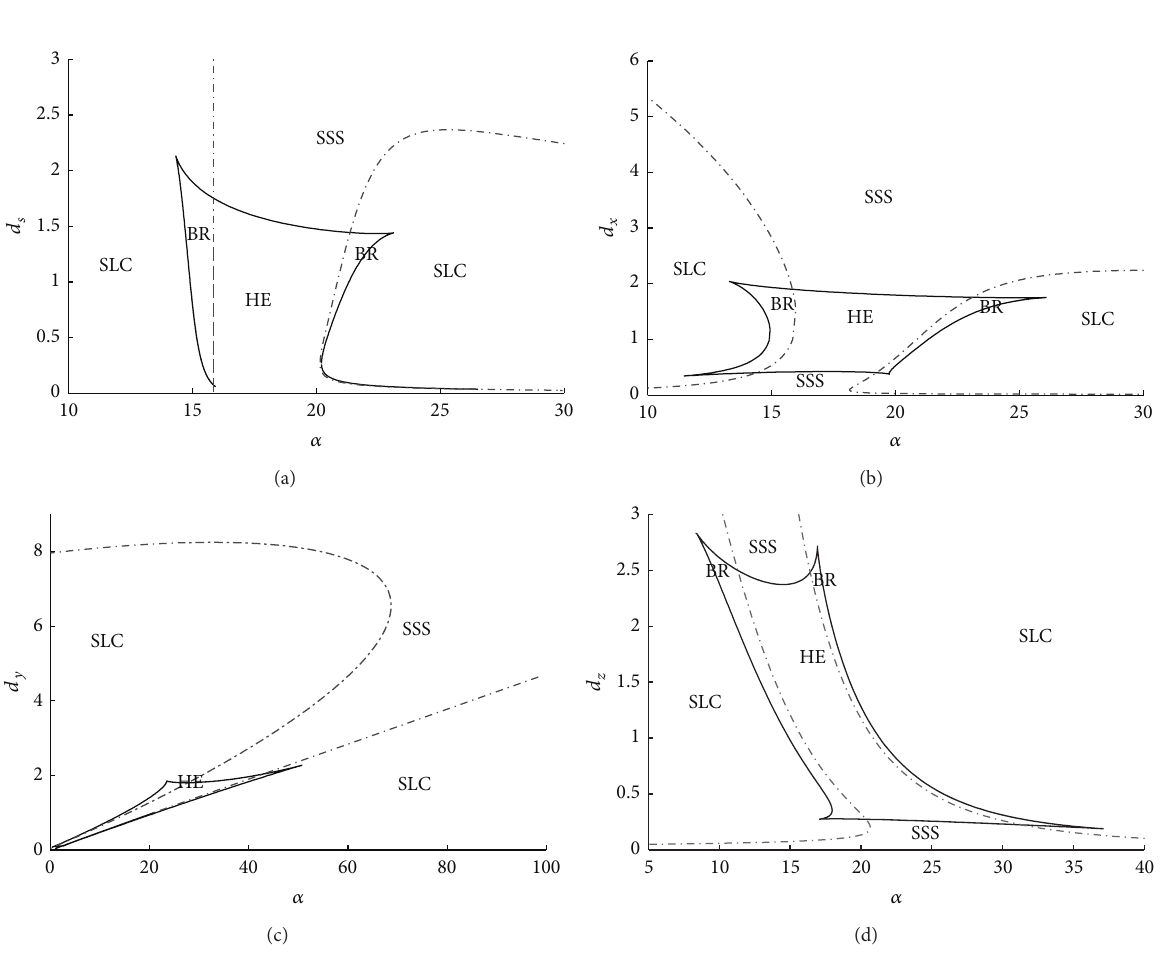
lower limit. However, there are minimum and maximum of 𝛼